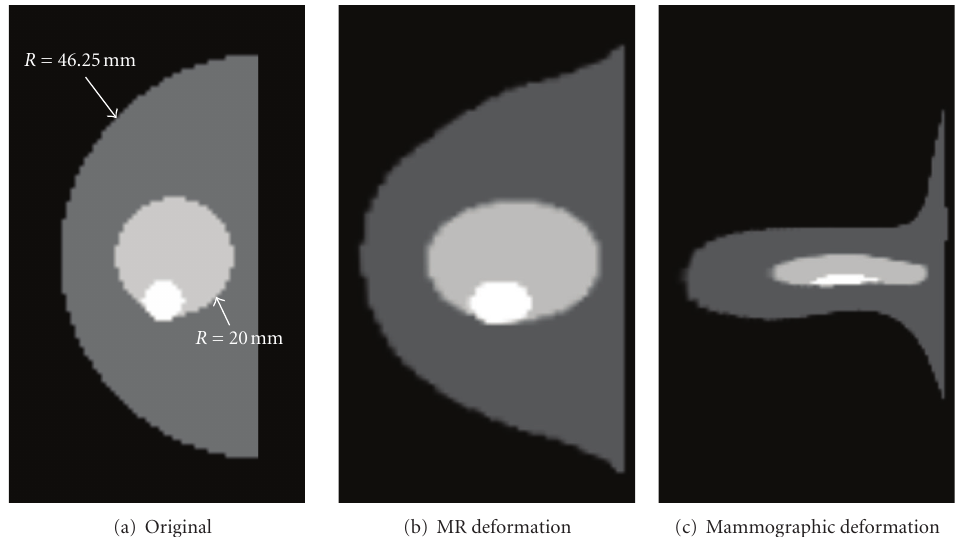
Figure 6: Slices taken from the centre of the numerical phantom following deformation via finite element modelling.